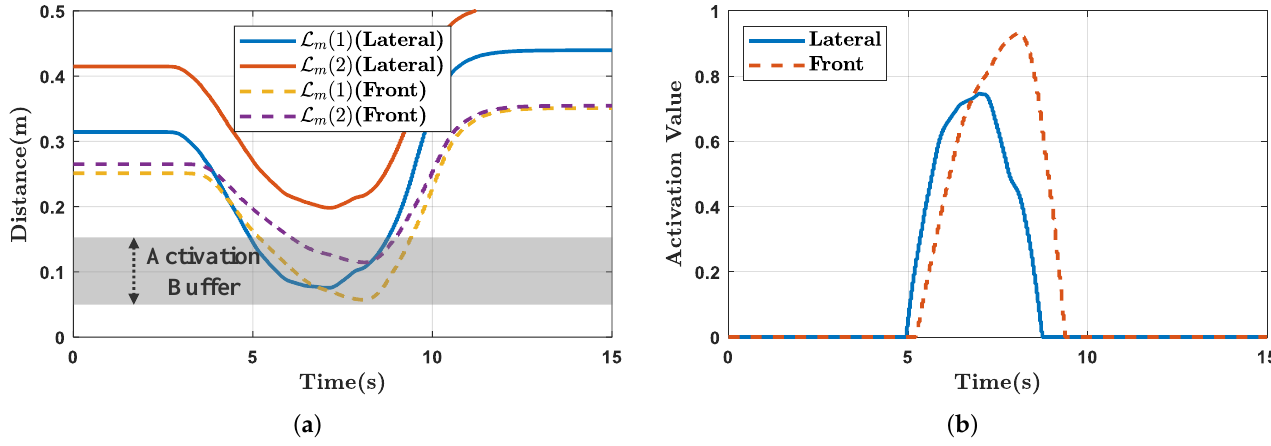
Figure 14. Experimental results of self-collision avoidance while manually guiding the end-effector. ( a ) The distances between the link pairs ( L m ( 1 ) , L m ( 2 ) ); ( b ) the value of the activation